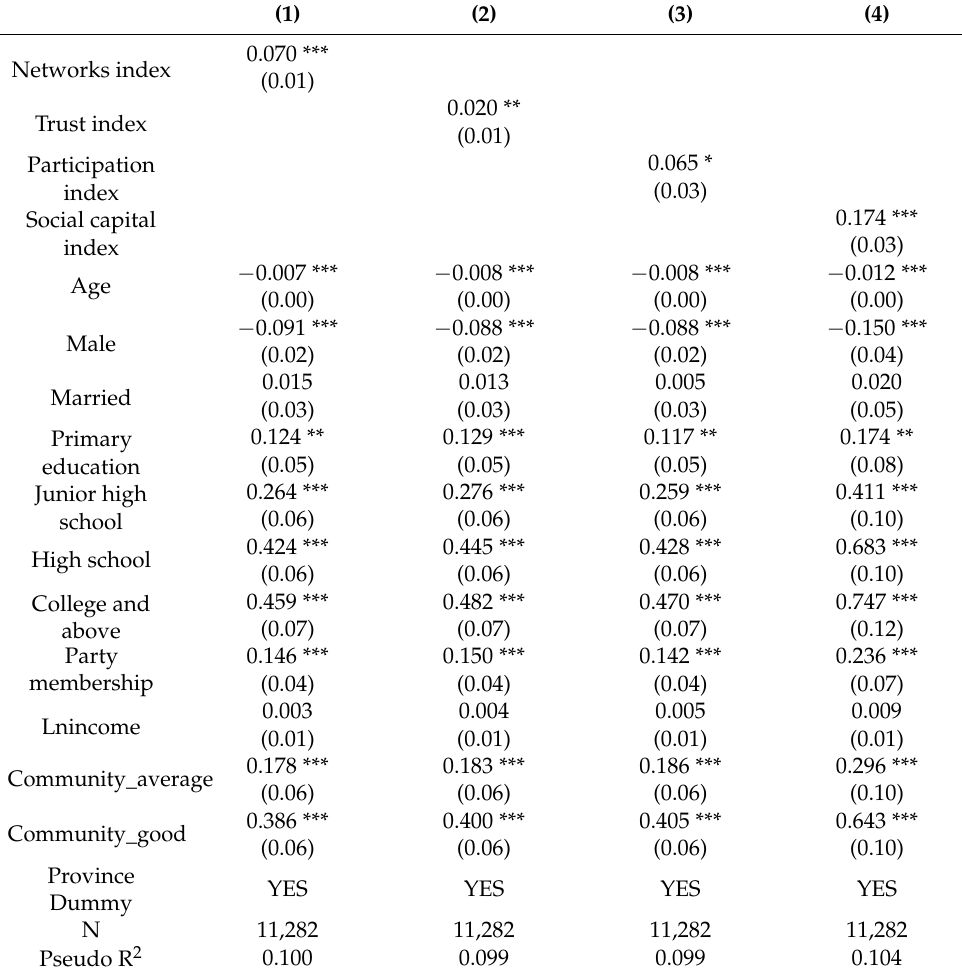
Table 3. Ordered probit model results of social capital on waste-separation